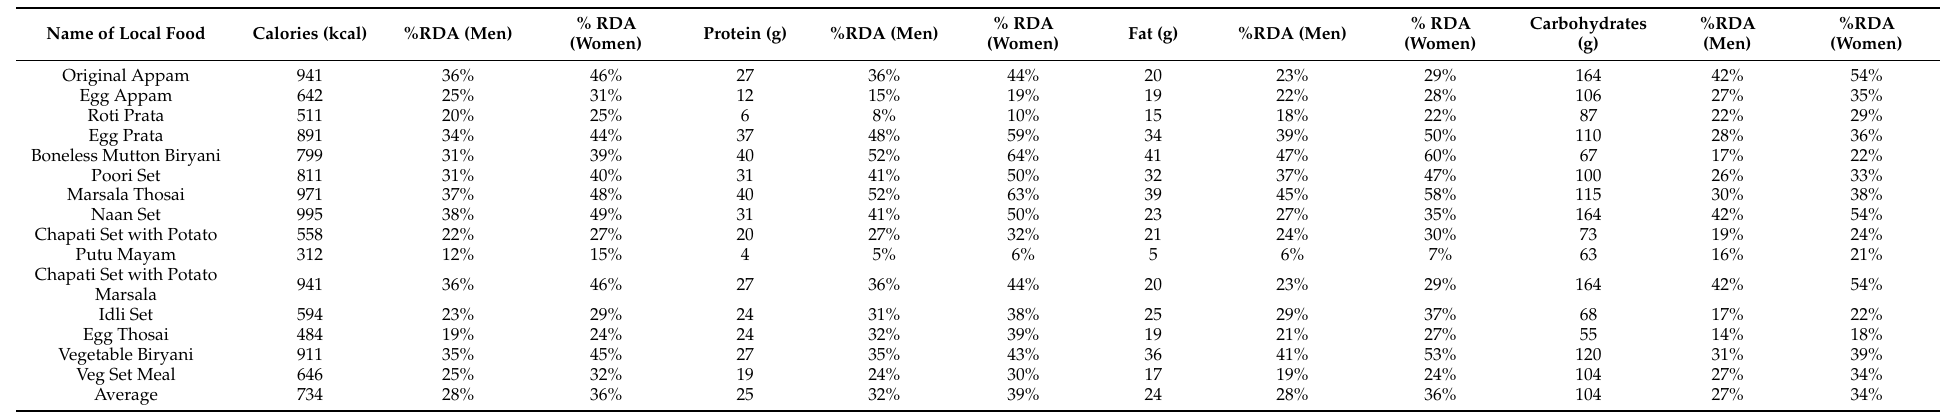
Table 6. Energy and macronutrient content and the %RDA of the commonly consumed Indian cuisines.